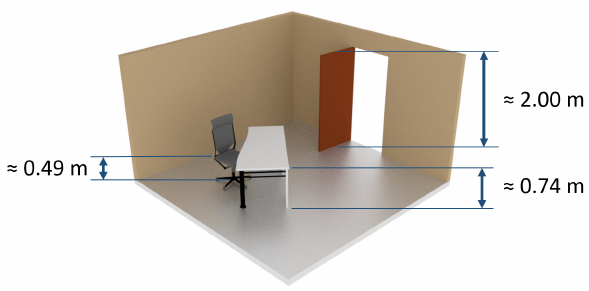
Figure 1: Schematic diagram of commonly found furniture (chair, desk, and a